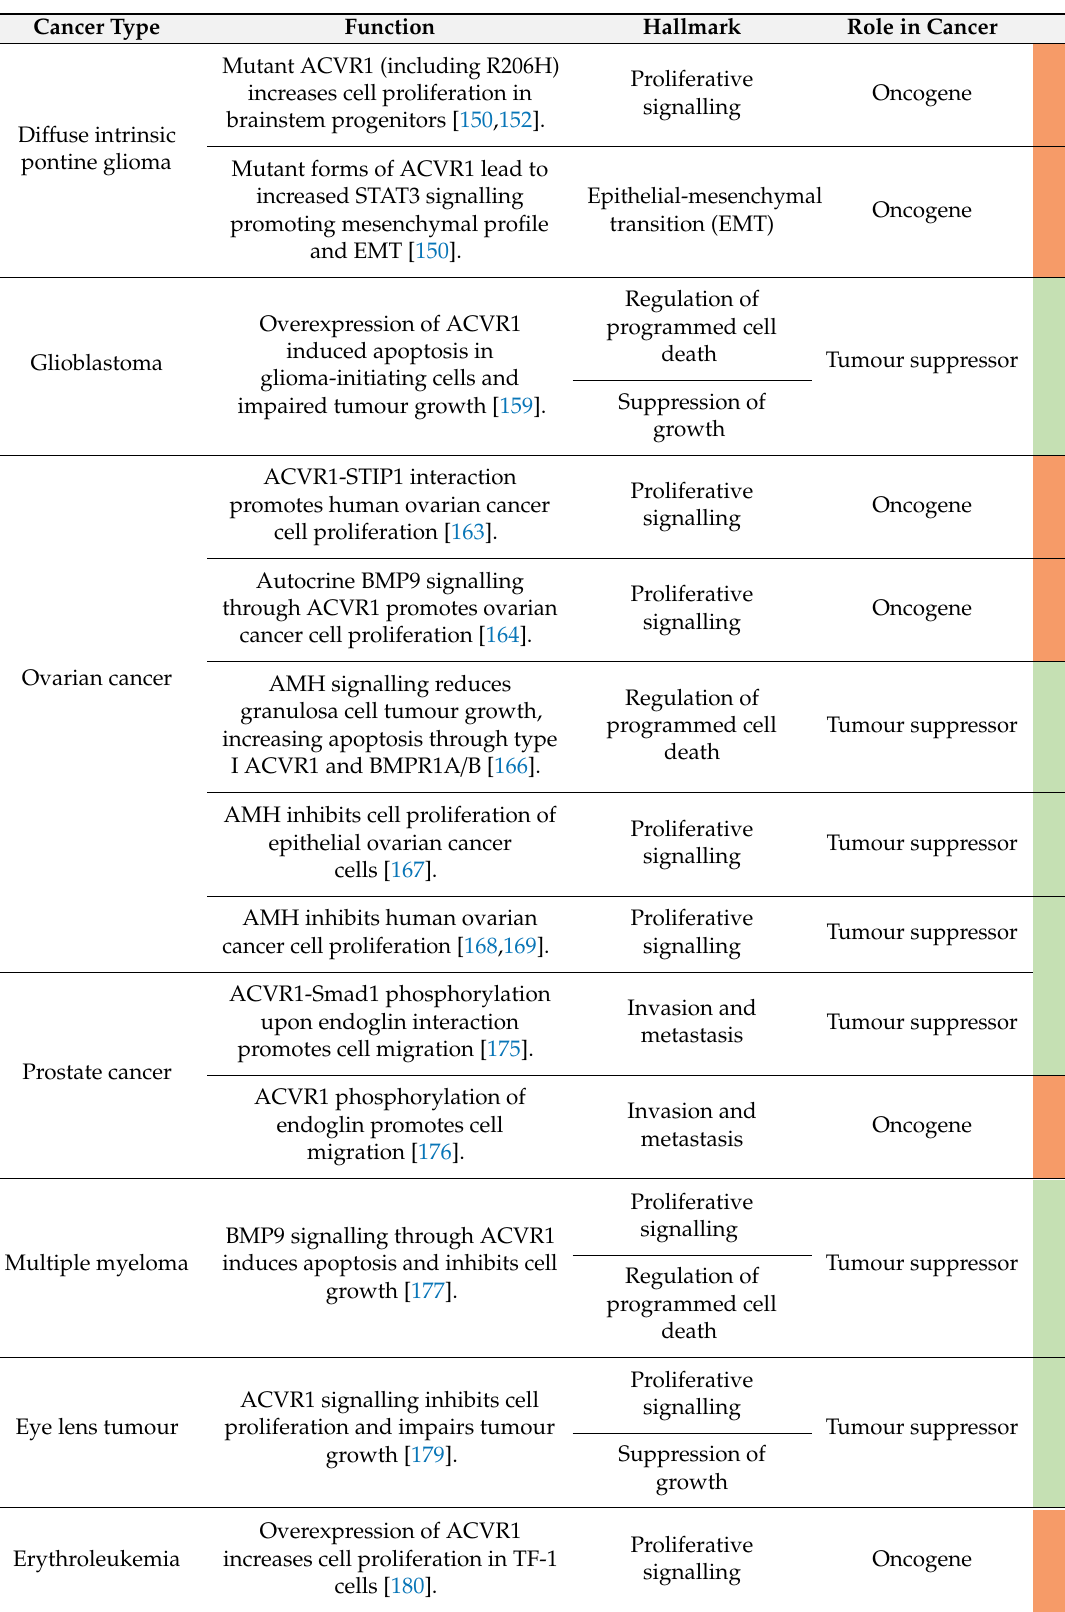
Table 1. Role of ACVR1 in di ff erent cancer